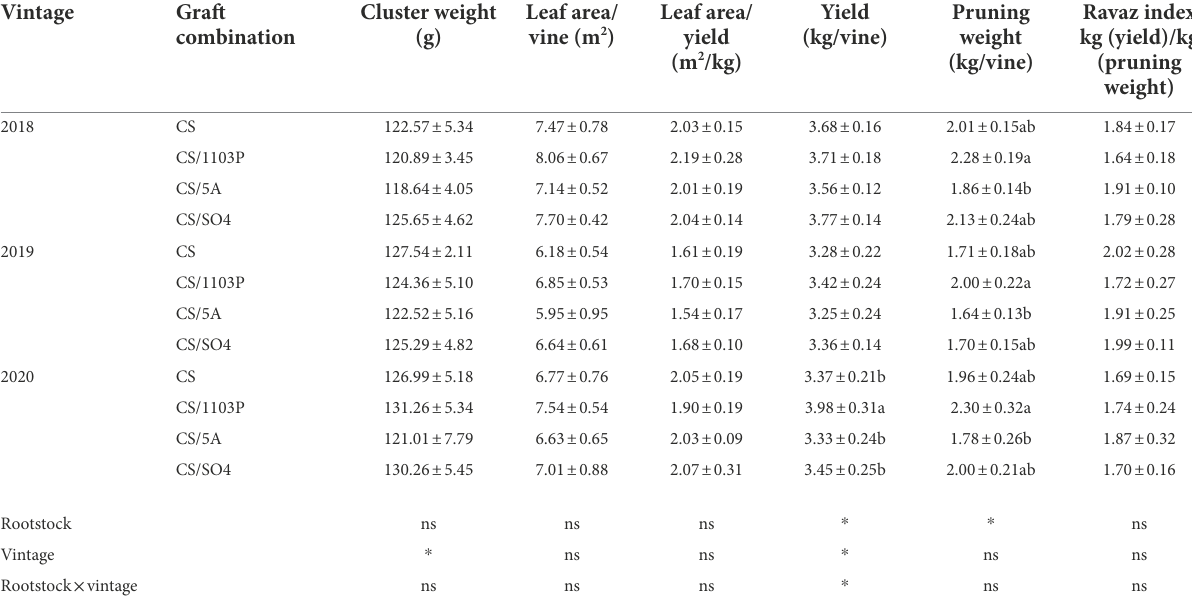
TABLE 1 Effects of rootstock on vine growth parameters.